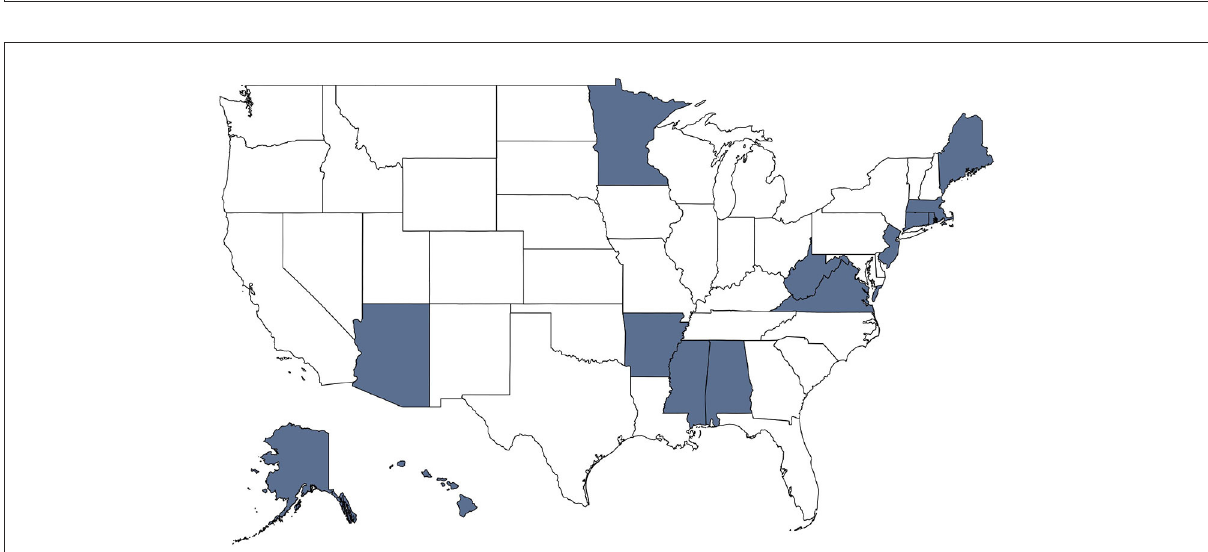
FIGURE6 States’ adoption of revised birth certificate form by 2011. This map indicates with blue shading the 11 states that had not begun recording births using the 2003 revised birth certificate form before